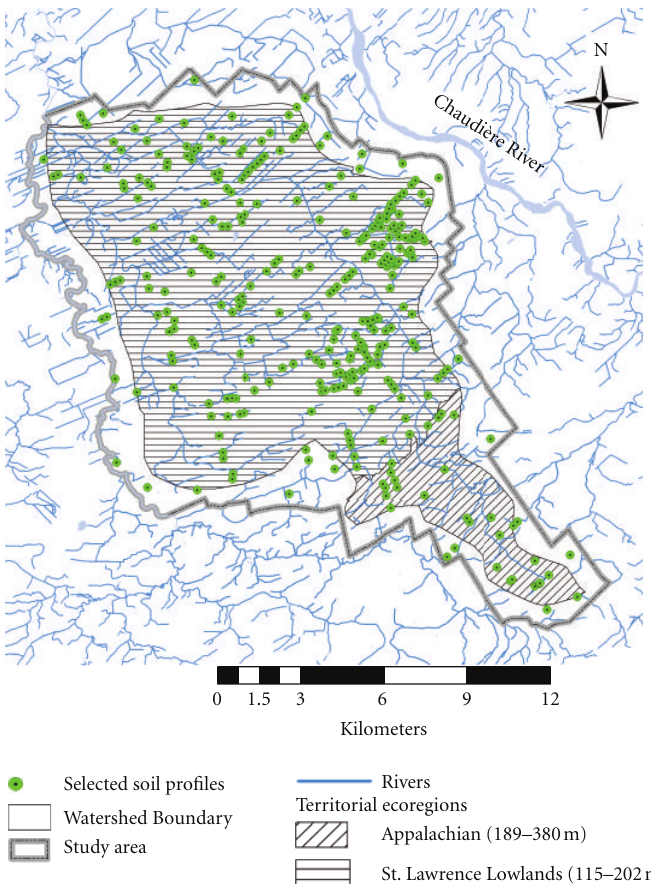
Figure 1: Map showing the study area (Bras d’Henri watershed, QC, Canada) with the localisation of the 327 georeferenced soil profiles used in the training dataset. The two physiographical zones are